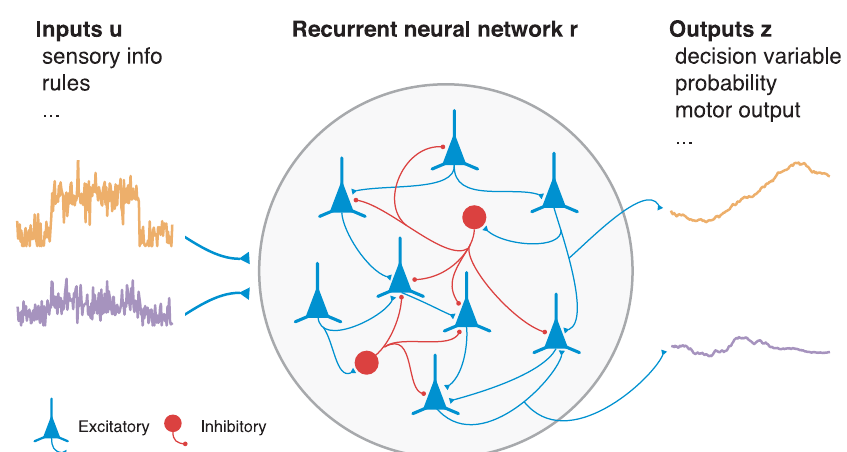
Fig 1. Recurrent neural network (RNN). A trained RNN of excitatory and inhibitory rate units r ( t ) receives time-varying inputs u ( t ) and produces the desired time-varying outputs z ( t ). Inputs encode task-relevant sensory information or internal rules, while outputs indicate a decision in the form of an abstract decision variable, probability distribution, or direct motor output. Only the recurrent units have their own dynamics: inputs are considered to be given and the outputs are read out from the recurrent units. Each unit of an RNN can be interpreted as the temporally smoothed firing rate of a single neuron or the spatial average of a group of similarly tuned